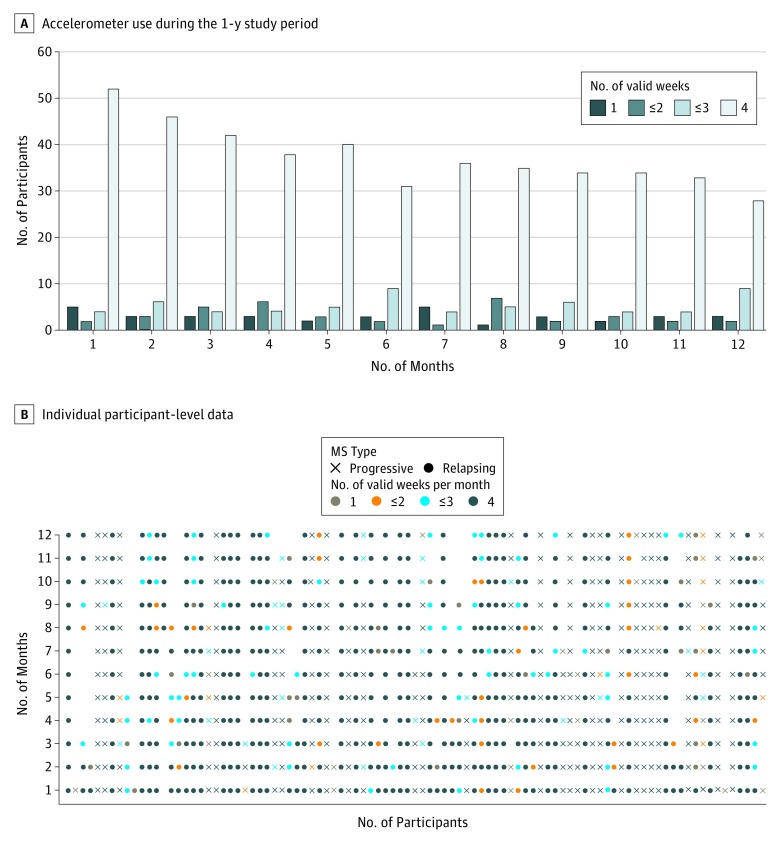
Accelerometer Use in a Prospective Research Cohort of Individuals With Multiple Sclerosis (MS) During a 1-Year Period A, Accelerometer use during the 1-year study period. Each bar represents the number of participants with valid Fitbit data (≥128 average daily steps per day, ≥3 days per week) during the 1-year study. B, Individual participant-level data by month, depicting periods of use and disuse of the wrist-worn accelerometer for 12 months. Each dot represents valid accelerometer data collected for 1 individual participant for that month.